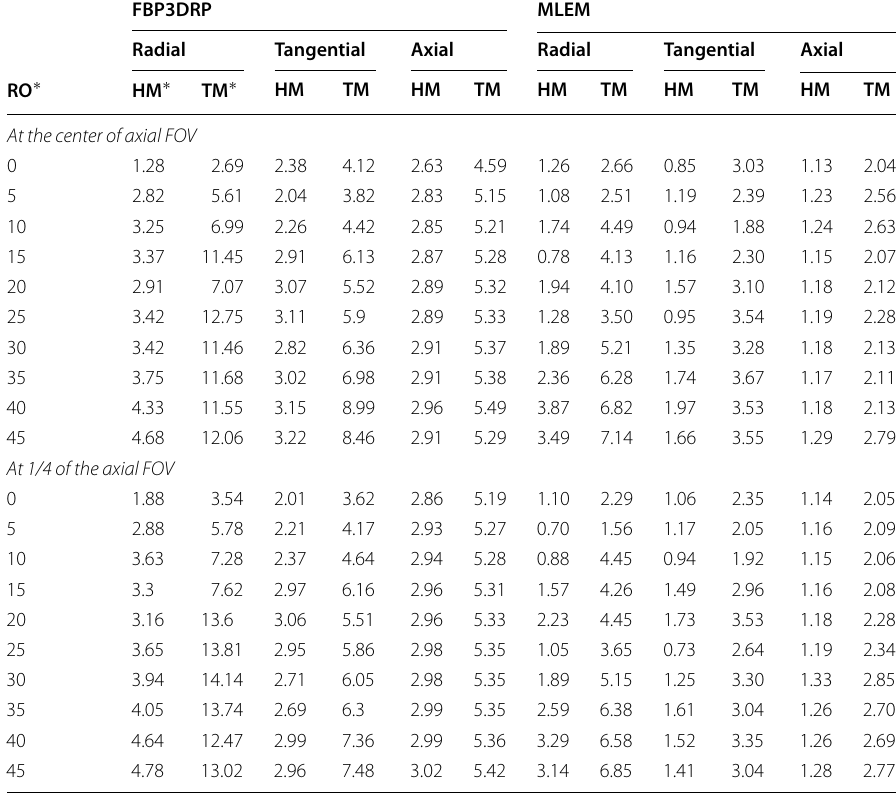
*RO Radial Offset; HM =